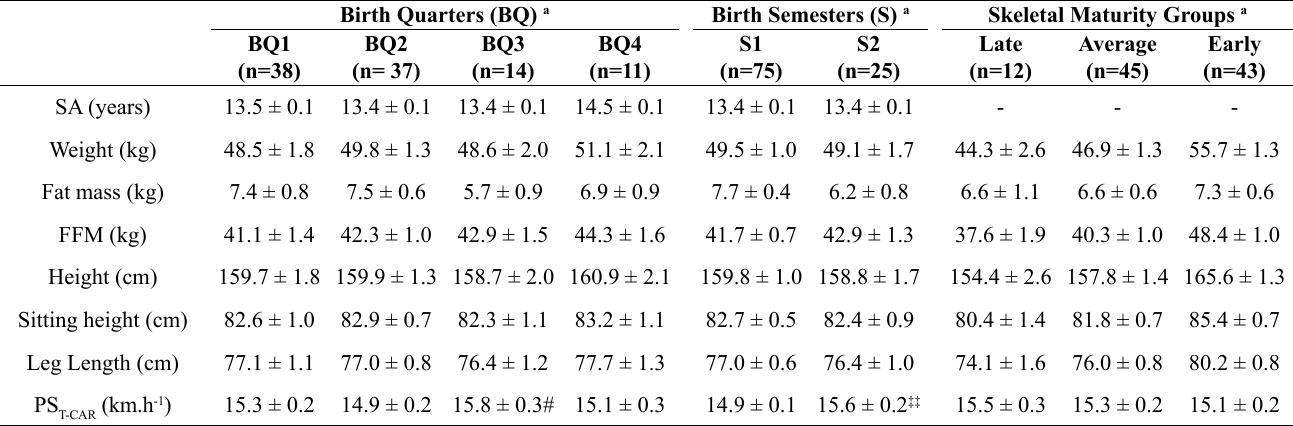
Table 2. Age-adjusted means ± standard errors by birth quarters (BQ), birth semesters (S) and skeletal maturity groups for the total sample of youth soccer players (n=100).